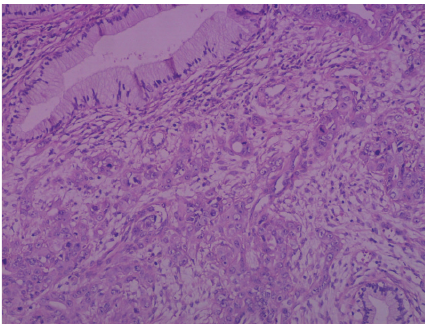
Figure 3: Metastatic cervical wall infiltration, surrounded by nor- mal endocervical glands.